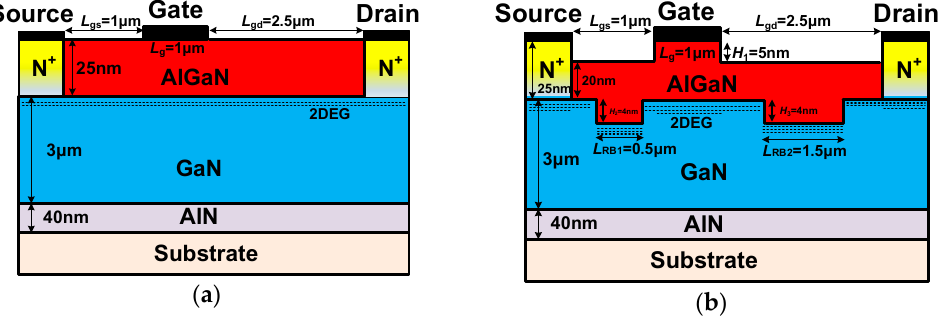
Figure 1. Schematic cross sections of the ( a ) conventional high-electron-mobility transistor (HEMT), and ( b ) proposed HEMT with a high gate and a multi-recessed buffer (HGMRB).